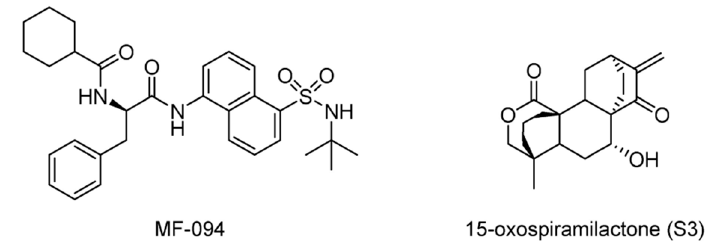
Figure 26. Structures of reported USP30